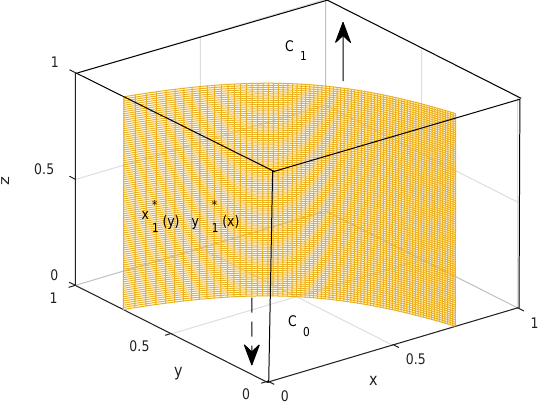
Figure 3. Behavior evolution direction of the construction worker under the condition of C W 1 > L W + C W 2 − P EW .